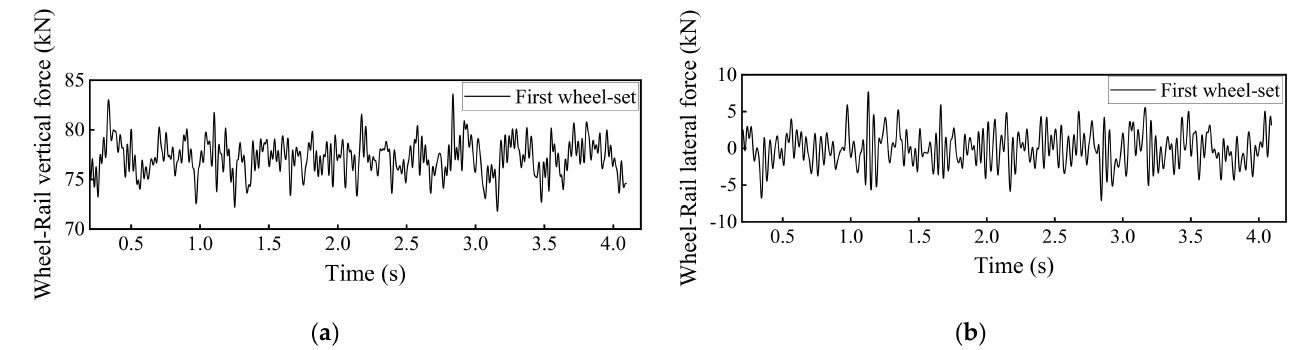
Figure 13. Model-calculated wheel-rail contact forces in the ( a ) vertical direction and ( b ) lateral direction.